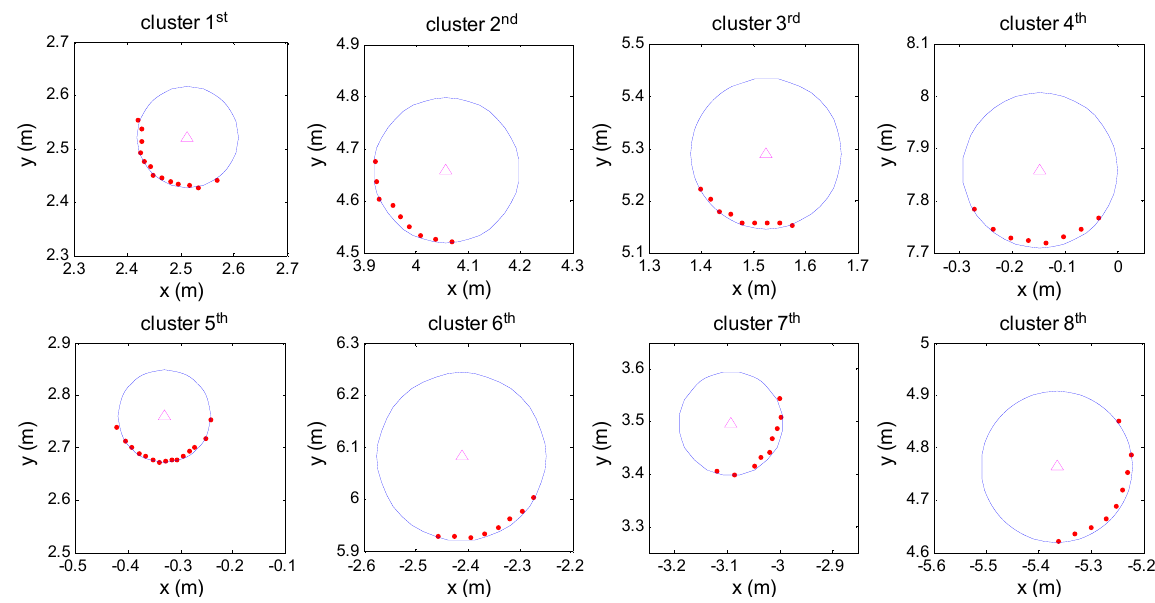
Figure 6. The calculation results.